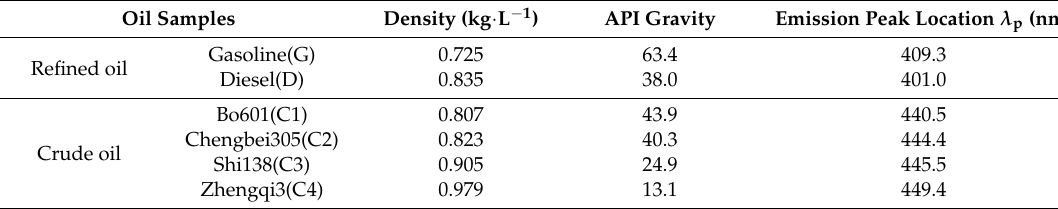
Table 1. Physical and spectral parameters of the oil samples used in the